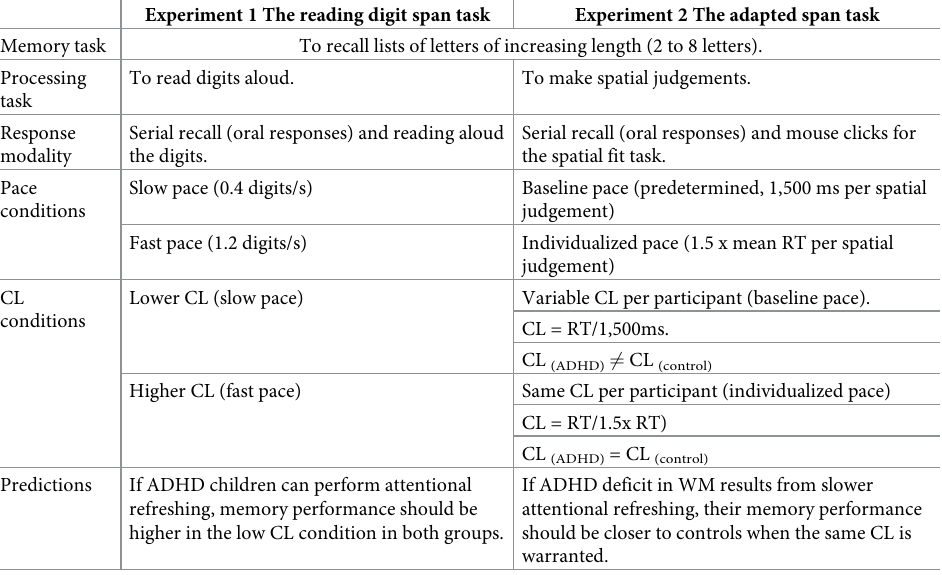
Table 1. Summary of the experimental design of Experiment 1 and Experiment 2. Experiment 1 The reading digit span